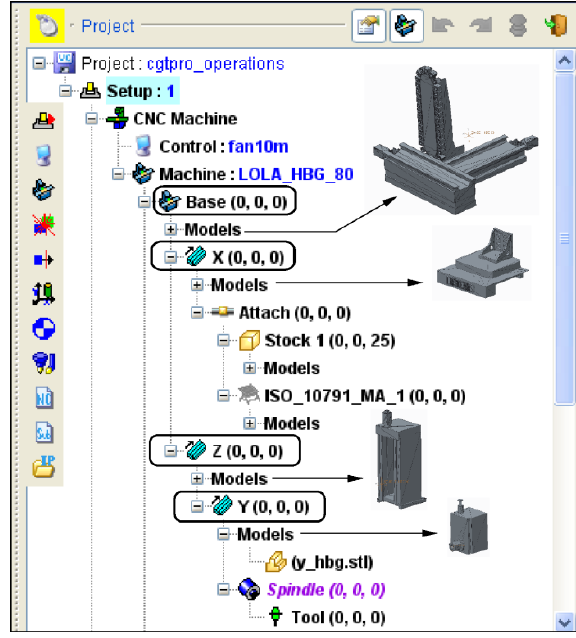
Figure 8.The hierarchical tree structure of the machine tools